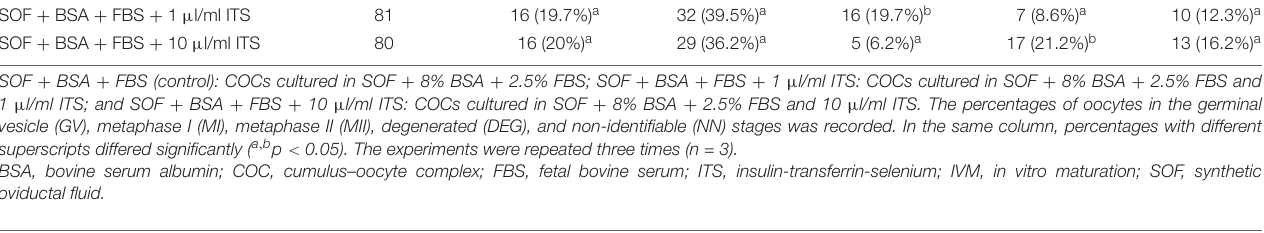
TABLE 4 | In vitro maturation of canine oocytes in SOF + BSA + FBS medium for 48 h under two different O 2 tension atmospheres in the presence or absence of ITS. Group No. oocytes GV MI MII DEG NN SOF + BSA + FBS + high O 2